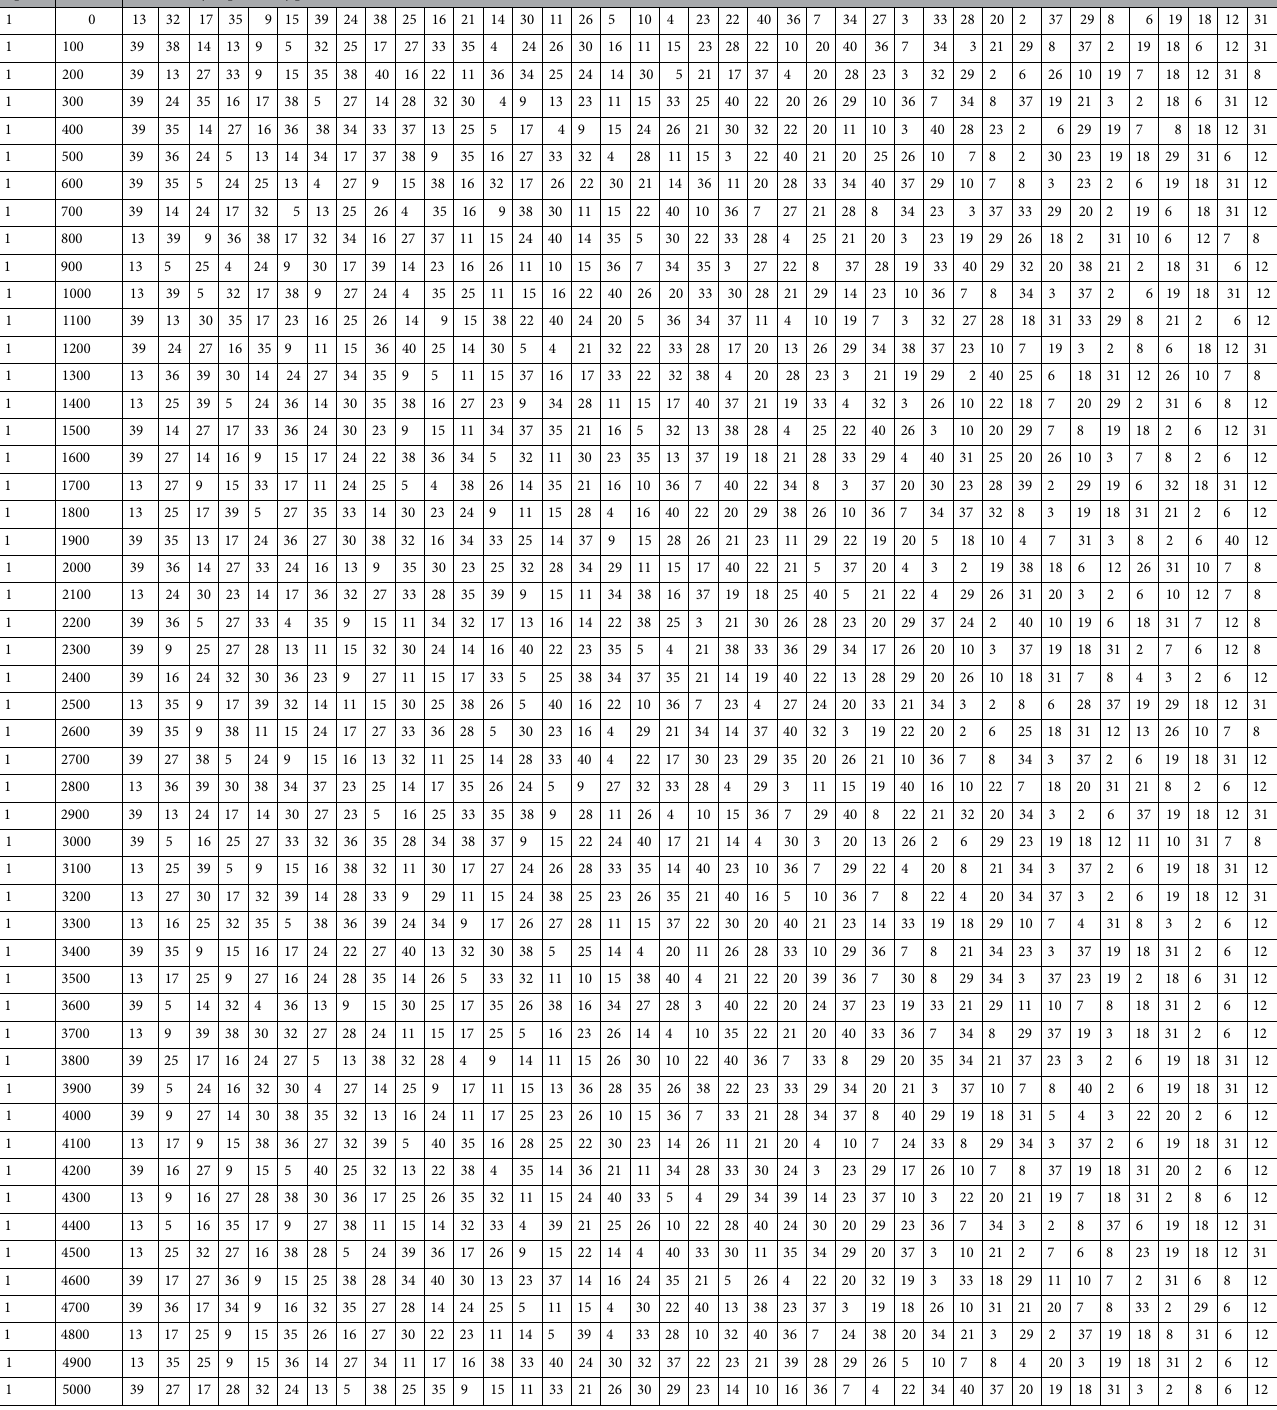
Table 2. BA-generated disassembly sequence results at q =